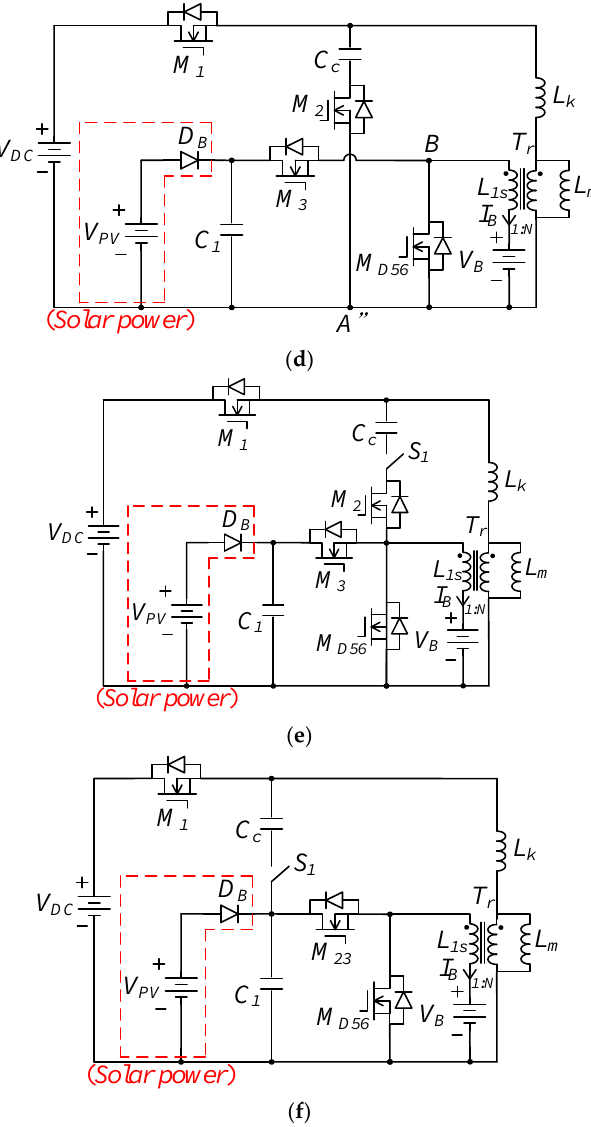
Figure 5. Circuit derivation of the proposed hybrid converter with utility line and PV arrays sources for lithium battery charger system: ( a ).step 1, ( b ) step 2, ( c ) step 3, ( d ) step 4, ( e ) step 5 and ( f ) step6.